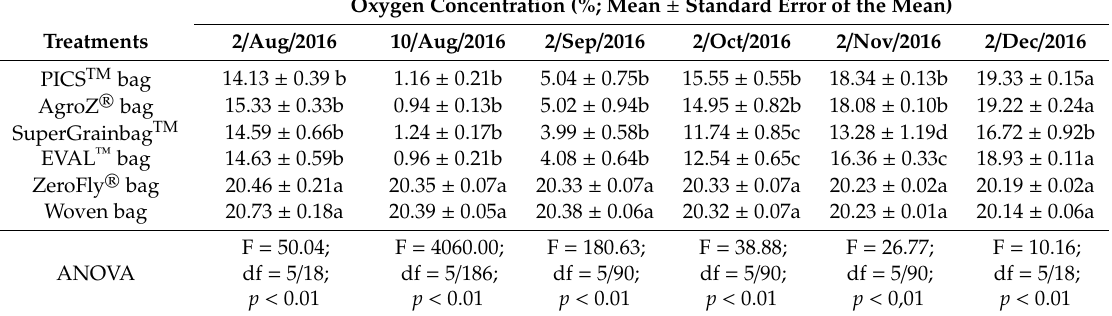
Table 1. Change in oxygen levels during the first four months in hermetic and non-hermetic bags filled with naturally infested cowpea stored for eight months in Maradi, Niger. Oxygen Concentration (%; Mean ± Standard Error of the Mean)